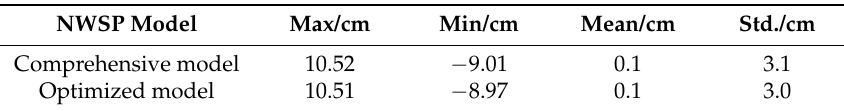
Table 6. Statistical parameters of the comprehensive and optimized near water surface penetration (NWSP) model errors.